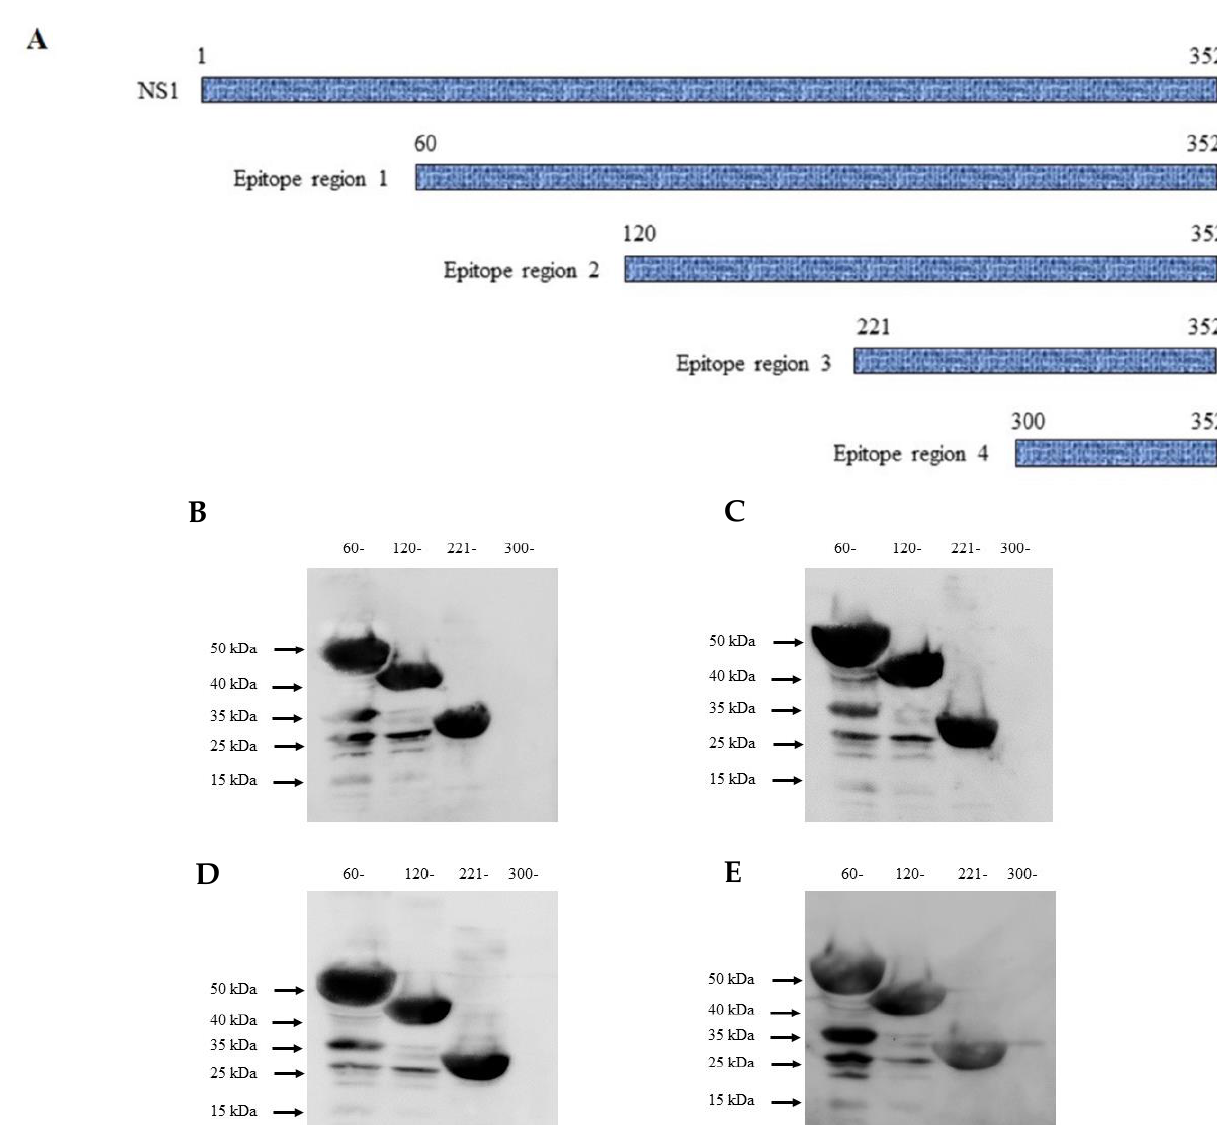
Figure 6. Epitope mapping of anti-DENV NS1 HuMAbs: ( A ) The truncated NS1 protein regions are constructed and expressed in E. Coli BL21DE3. Lysates expressing truncated NS1 proteins are loaded to SDS-PAGE, and the proteins were transferred to the PVDF membrane. Each epitope regions is subsequently stained with DENV NS1 HuMAbs ( B ) HuMAb M20; ( C ) HuMAb M1; ( D ) HuMAb 238, and ( E ) HuMAb 8.